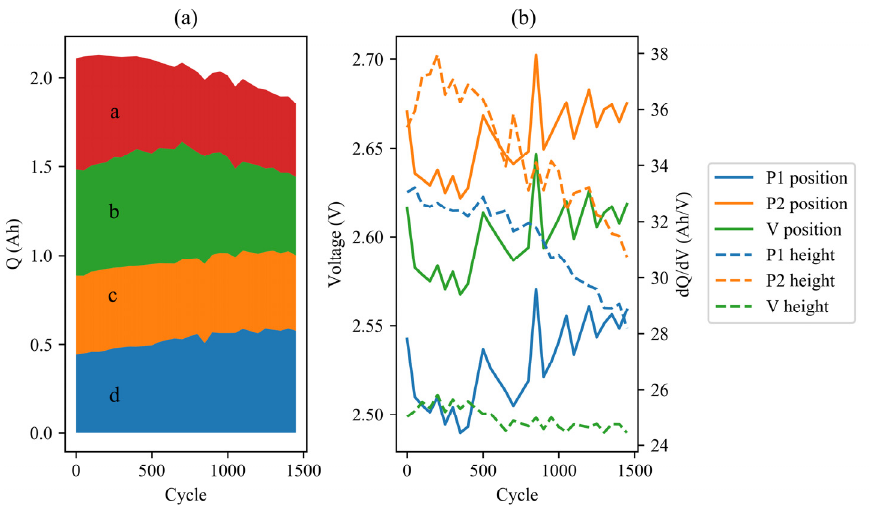
Figure 11. IC parameters (2 C) evolution of cell #7 during aging cycles: ( a ) area; ( b ) positions and heights of peaks.